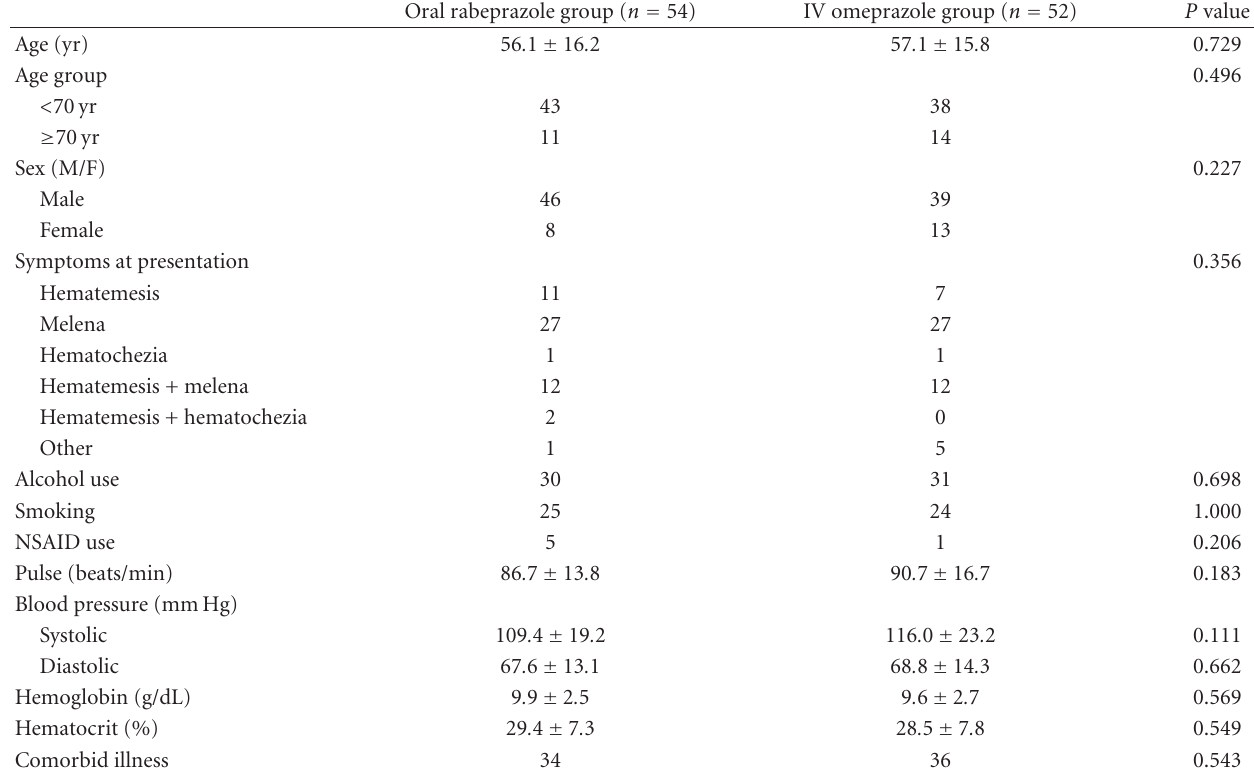
Table 1: Demographics (ITT